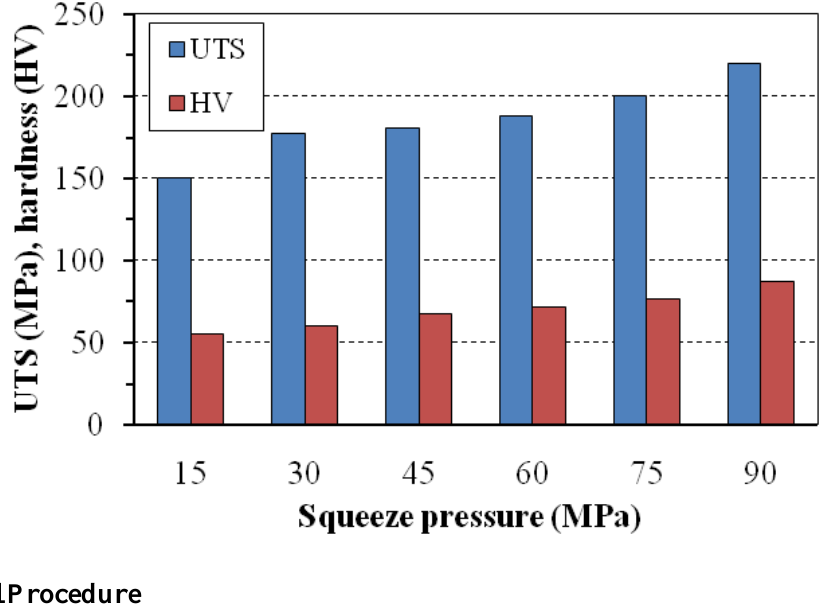
Figure 5. Ultimate tensile strength (UTS) and hardness of 2017 A Al alloy manufactured in various conditions.